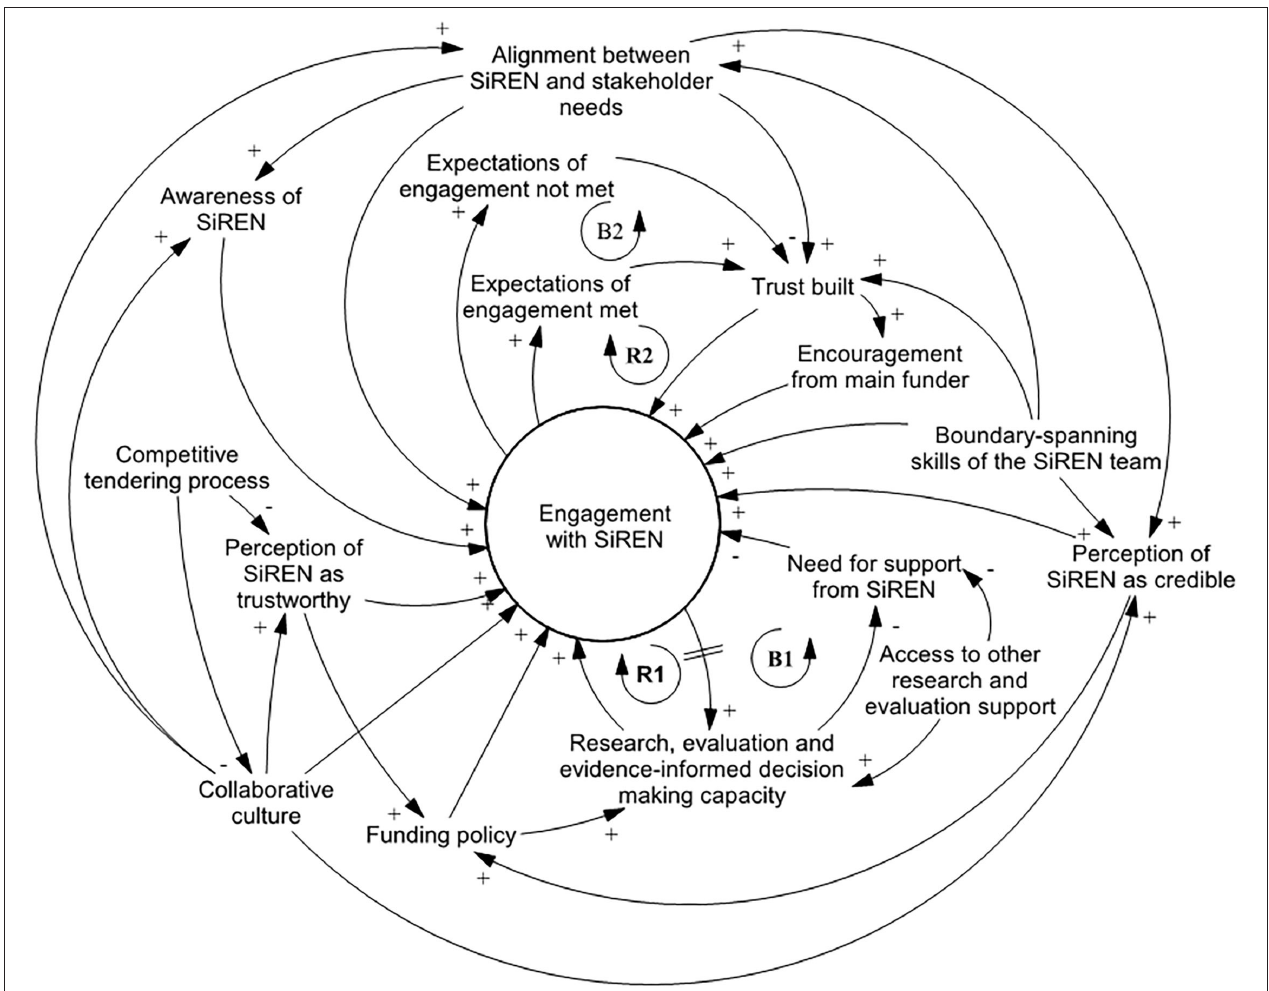
FIGURE 1 | Causal loop diagram depicting factors that influence engagement with